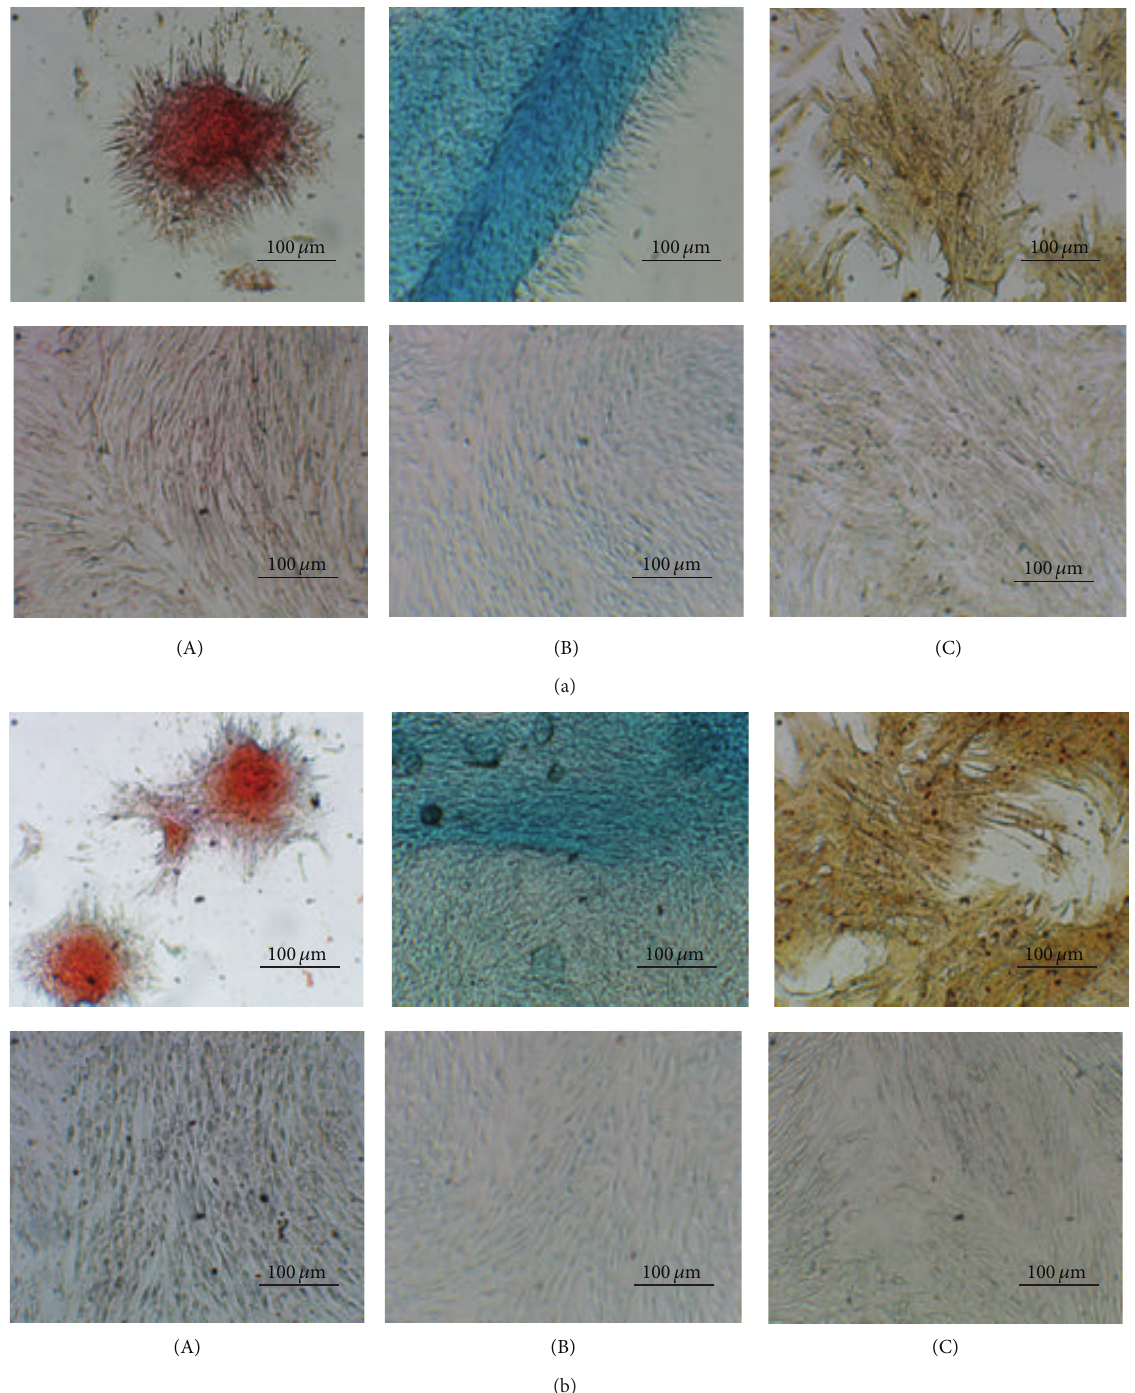
Figure 3: Mesodermal trilineage differentiation assays of eBM-MSCs. Representative images from one young (a) and one middle-aged (b) horse showing oil red-o (A), alcian blue (B), and alizarin red (C) staining of adipogenesis, chondrogenesis, and osteogenesis, respectively, after in vitro differentiation. Each undifferentiated control is shown in (b). Scale bar = 100 𝜇